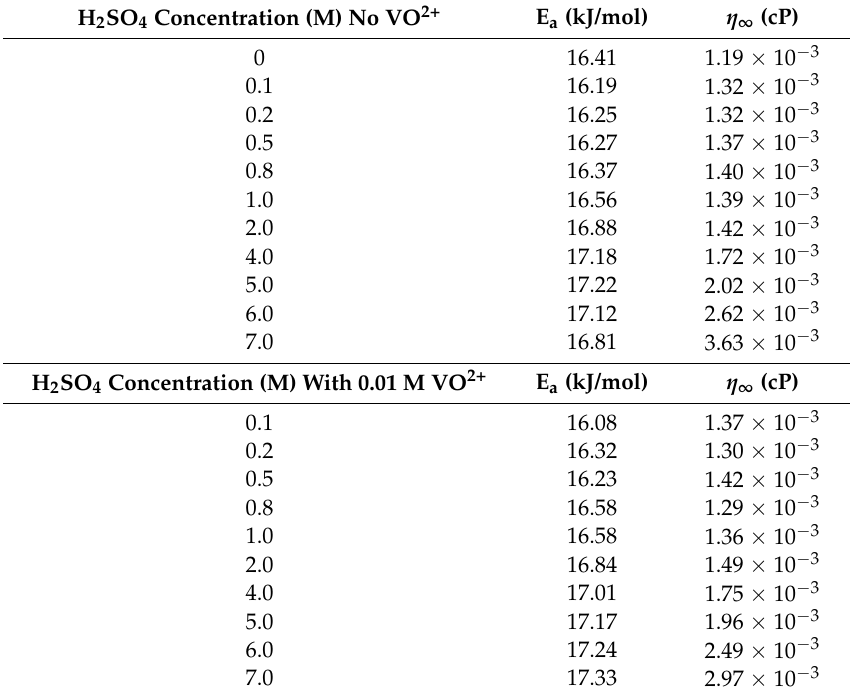
Table A3. Arrhenius parameters extracted from data in Figure